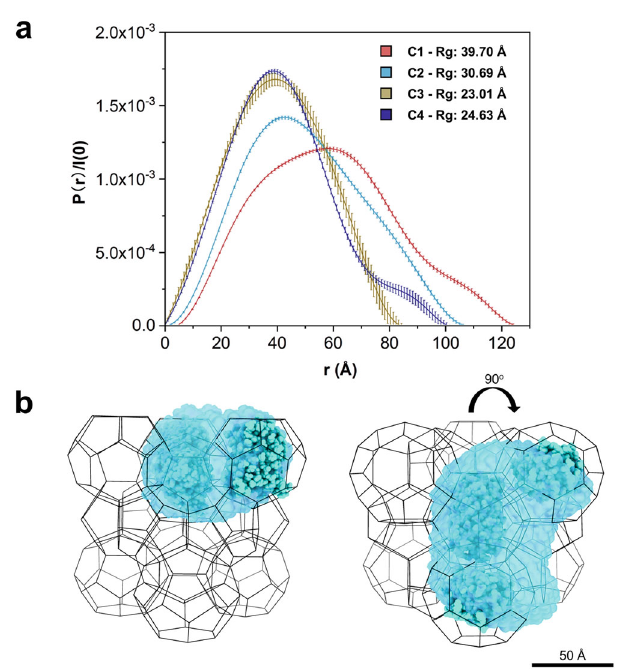
Fig. 4 | 3D reconstruction of d-GFP@MOF-919. a Experimental P(r) curves for d-GFPloadedintheMOF-919( C1 – C4 ). b Abinitiostructurereconstructionof C2 in structure of MOF-919. The blue-shaded region is reconstructed using scattering pro fi leof C2 ,andtheGFPatomicstructureisoverlaidbyblueballsforcomparison.